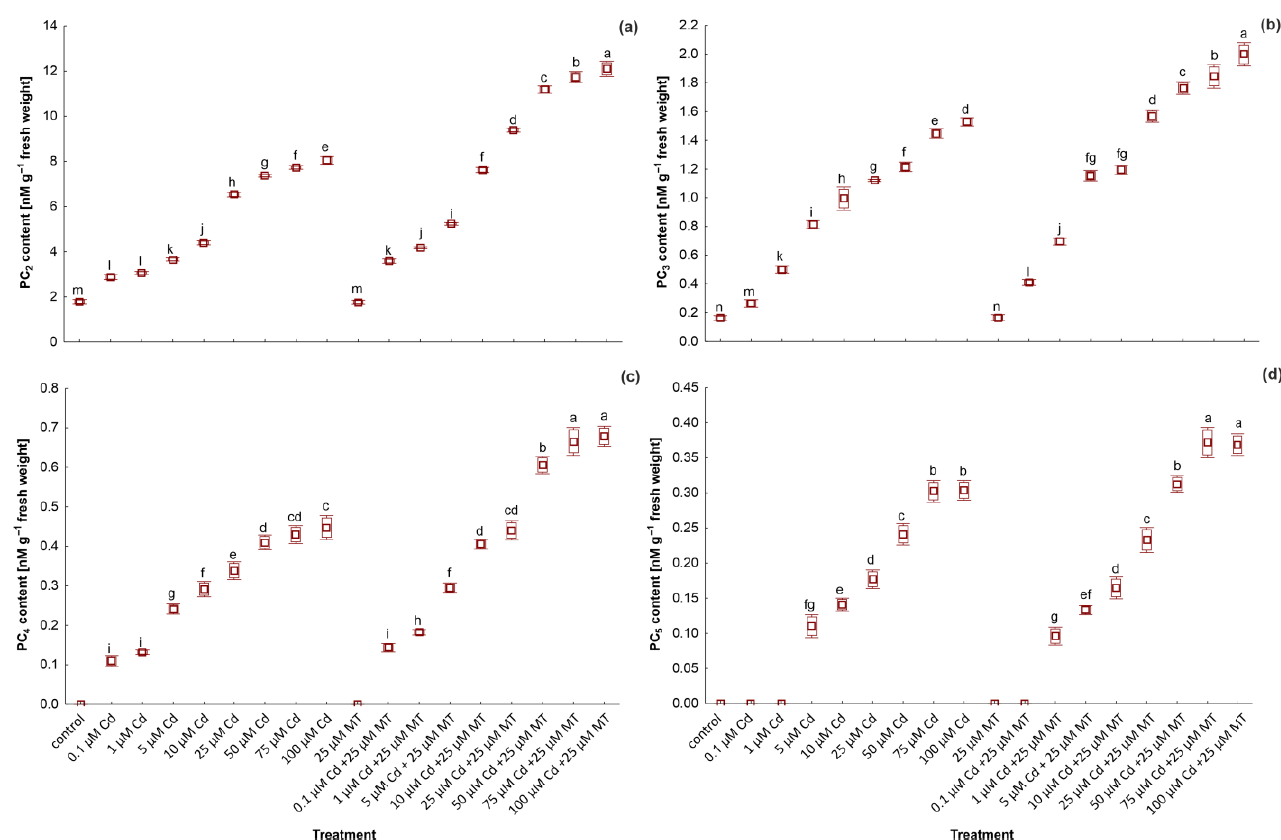
Figure 5. The content of phytochelatins (PC x ): PC 2 ( a ), PC 3 ( b ), PC 4 ( c ), and PC 5 ( d ) in W. arrhiza exposed to Cd or/with MT after 7 days of cultivation. The square represents the mean ( n = 5, biological replicate). The lower and upper hinges correspond to the lower and upper bounds of the 95% confidence interval of the means. The lower and upper whiskers extend from the hinge to the mean ± standard deviation. Means with the same letters are not significantly different ( p ≥ 0.05) according to Tukey’s post hoc test.